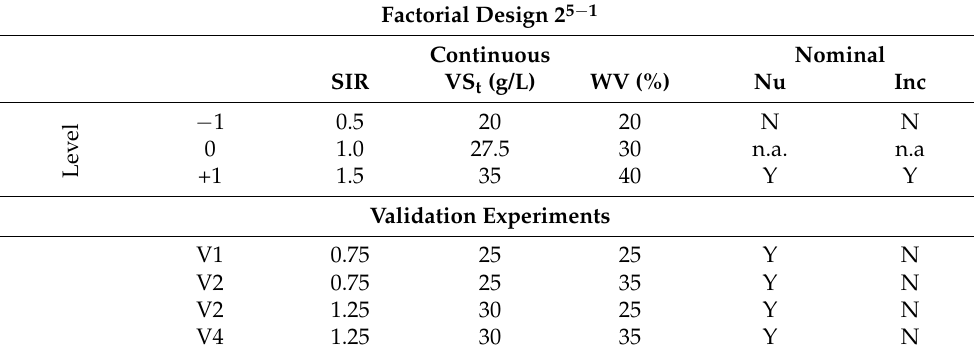
Table 1. Levels selected for each factor corresponding to the fractional factorial design 2 5 − 1 and operating conditions for the validation